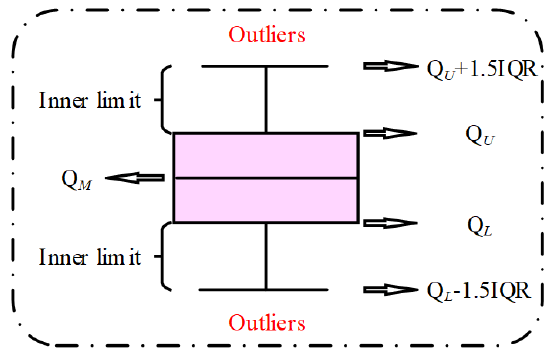
Figure 3: Realization principle of boxplot method